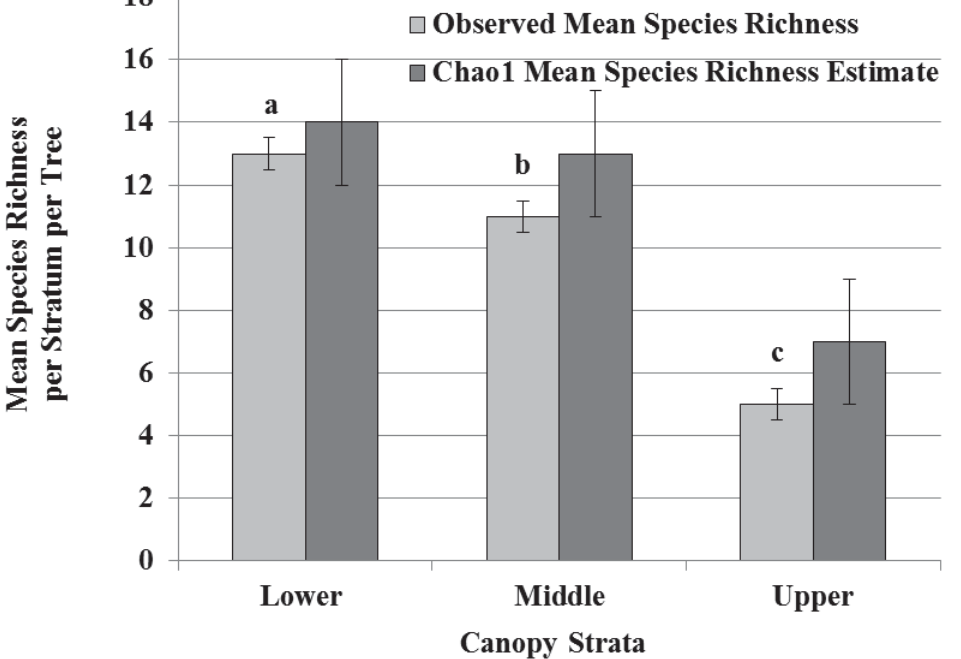
Figure 2. Observed mean species richness (mean number of species ± SE) for each stratum and Chao1 mean (± 95% CL) species richness estimate. Means ( n = 6) with different letters are significantly different (LSD test; p <